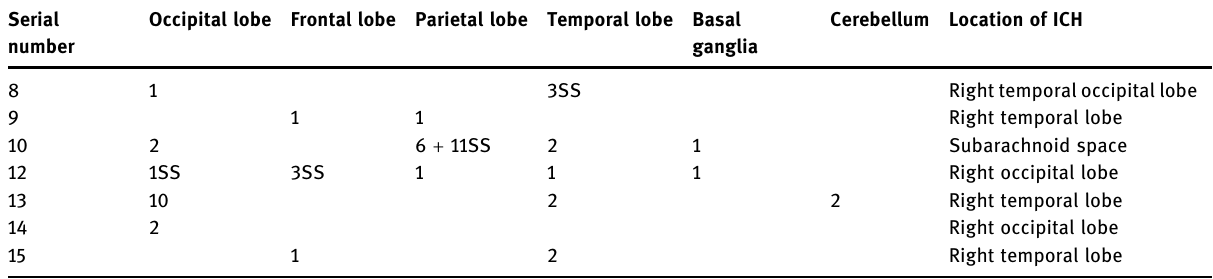
Table 3: The position of CMB or SS and recurrence of ICH in eight probable CAA patients with more than one time of hemorrhage ( n = 7 )